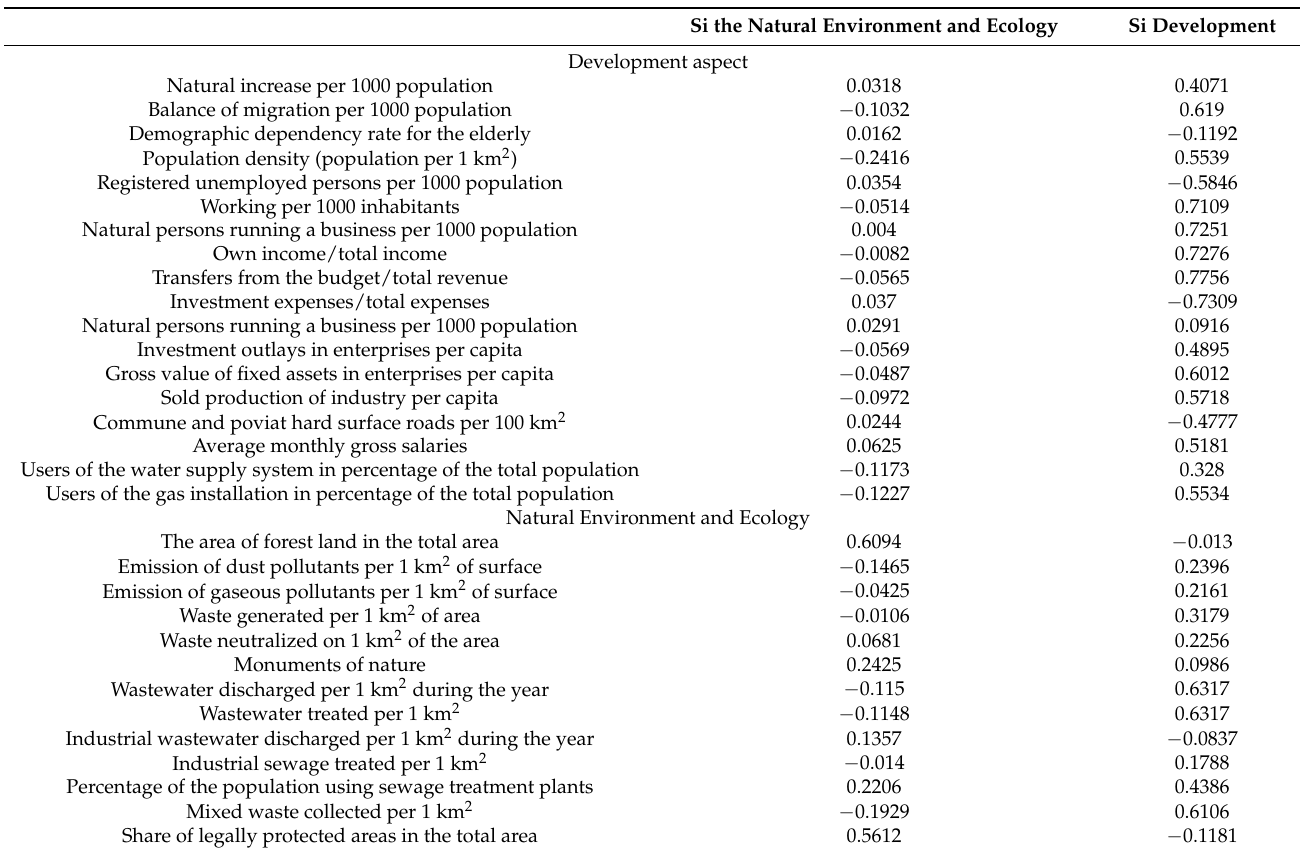
Table 5. Correlation between measures of the financial situation, demography and the labor market and socio-economic variables of counties in Poland (Pearson’s coefficient).